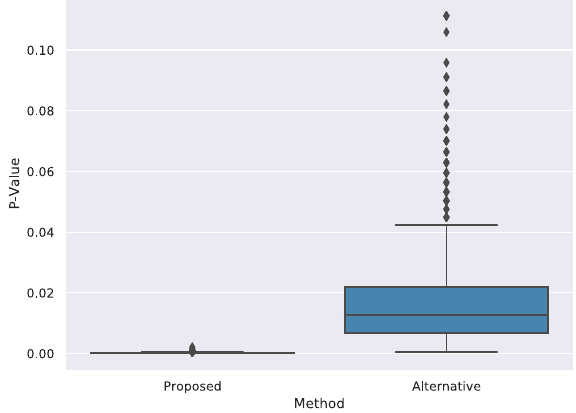
Figure 5. p -Value distribution distribution comparison.